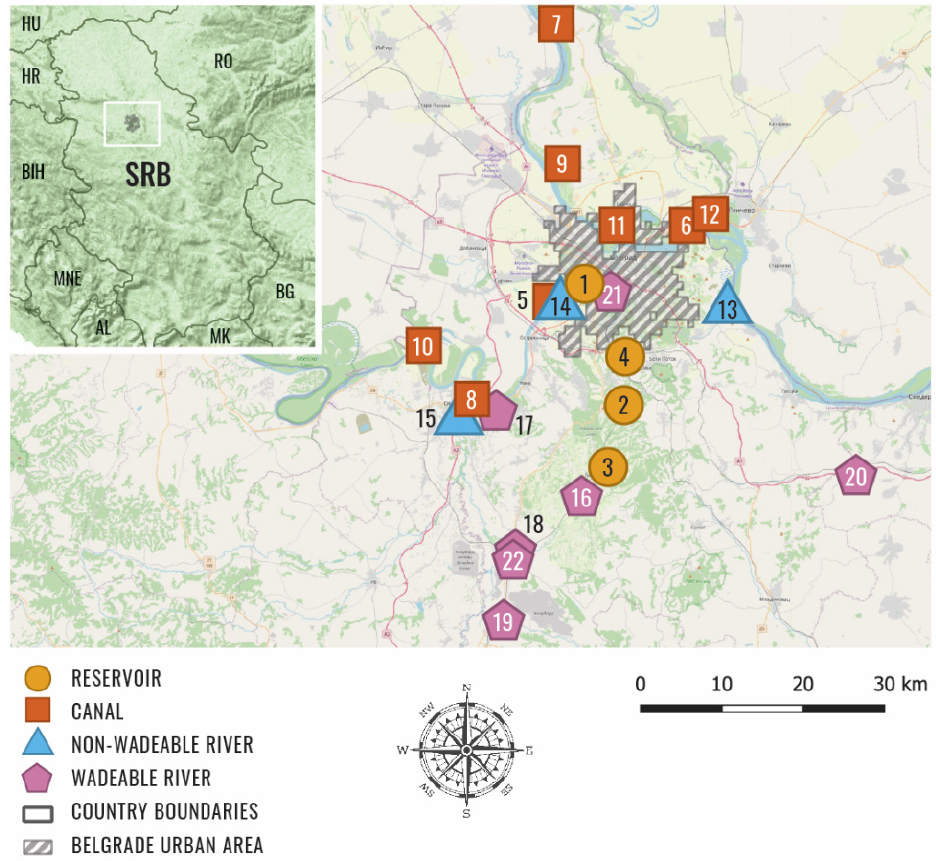
Figure 1. Sampling sites in the Belgrade functional urban area: 1. Savsko jezero, 2. Bela Reka, 3. Duboki potok, 4. Pariguz, 5. Galovica, 6. Kalovita, 7. Karaš, 8. Obrenova č ki kanal, 9. Agricultural Plant Belgrade (PKB), 10. Progarska Jar č ina, 11. Vizelj, 12. Sibnica, 13. Danube, 14. Sava, 15. Kolubara, 16. Barajevska reka, 17. Bari č ka reka, 18. Beljanica, 19. Peštan, 20. Ralja, 21. Top č iderska reka, 22. Turija.